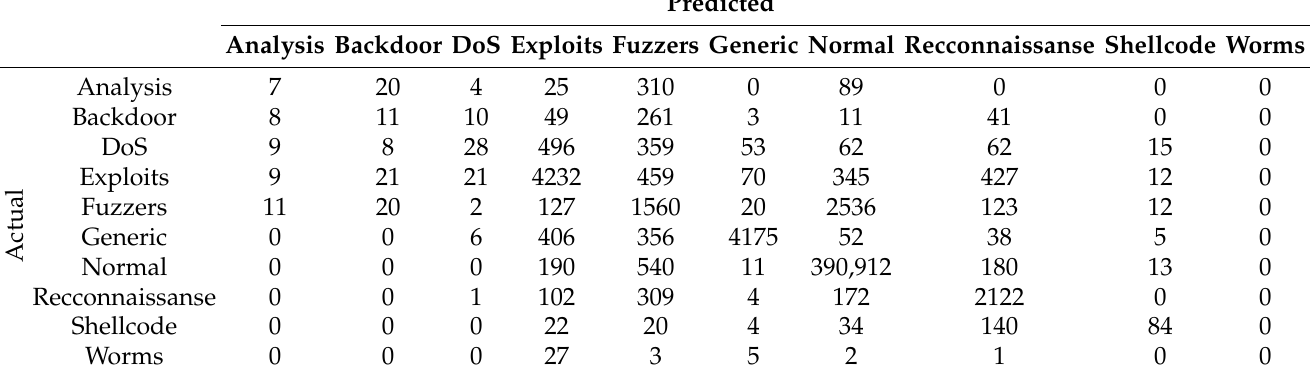
Table 17. Confusion matrix for UNSW-NB15 “full features” multiclass classification experiment.